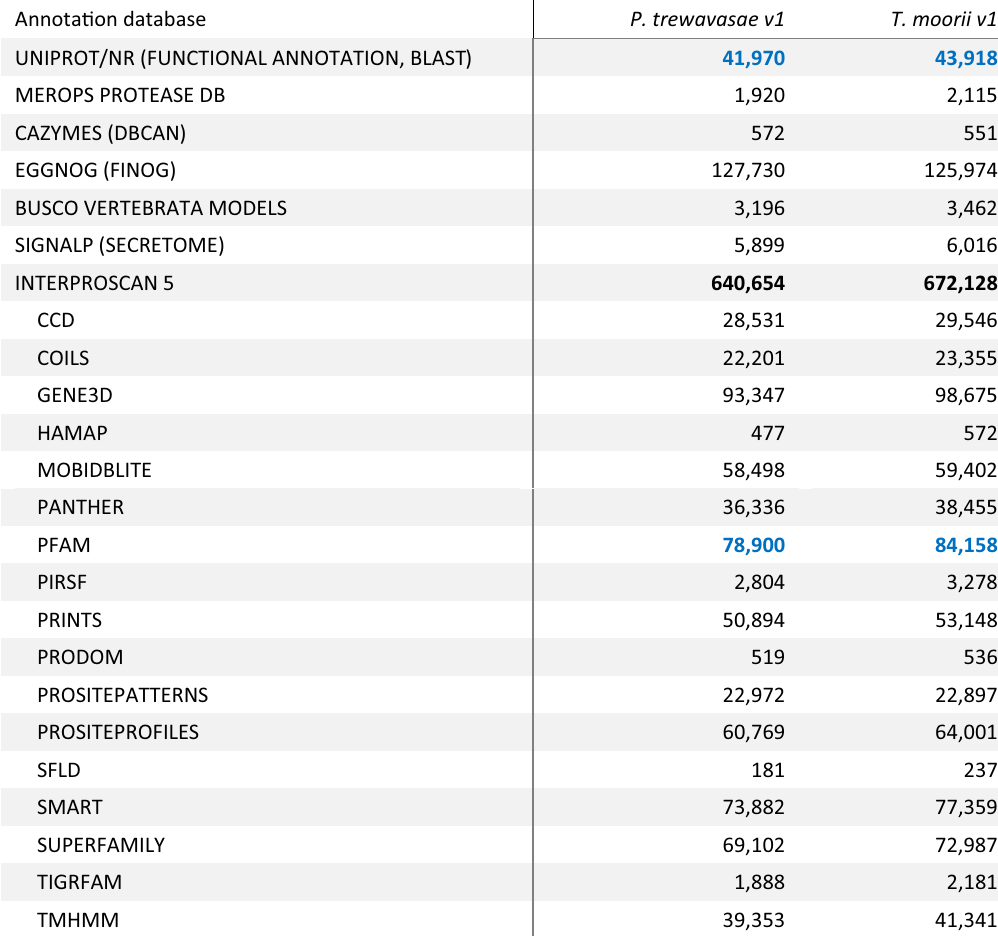
Table 3. Functional annotation statistics: The number of proteins found in UniProt and NR are given. Furthermore, the table contains the number of proteins with putative protease (Merops) and carbohydrate activity (CAZymes), the number of orthologs in fiNOG, the number of proteins matching the BUSCO vertrebrate models and the number of proteins with putative secretory signals (SignalP). Finally, the number of hits of the protein sequences for the various InterPro domain databases are